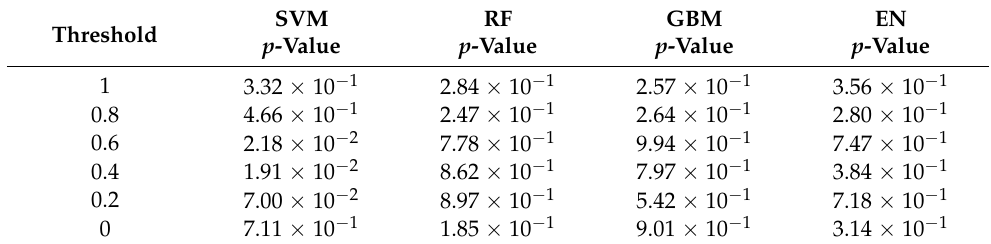
Table 4. Enrichment test of the predicted targets for SCZ (for targets of SCZ listed in OpenTargets).